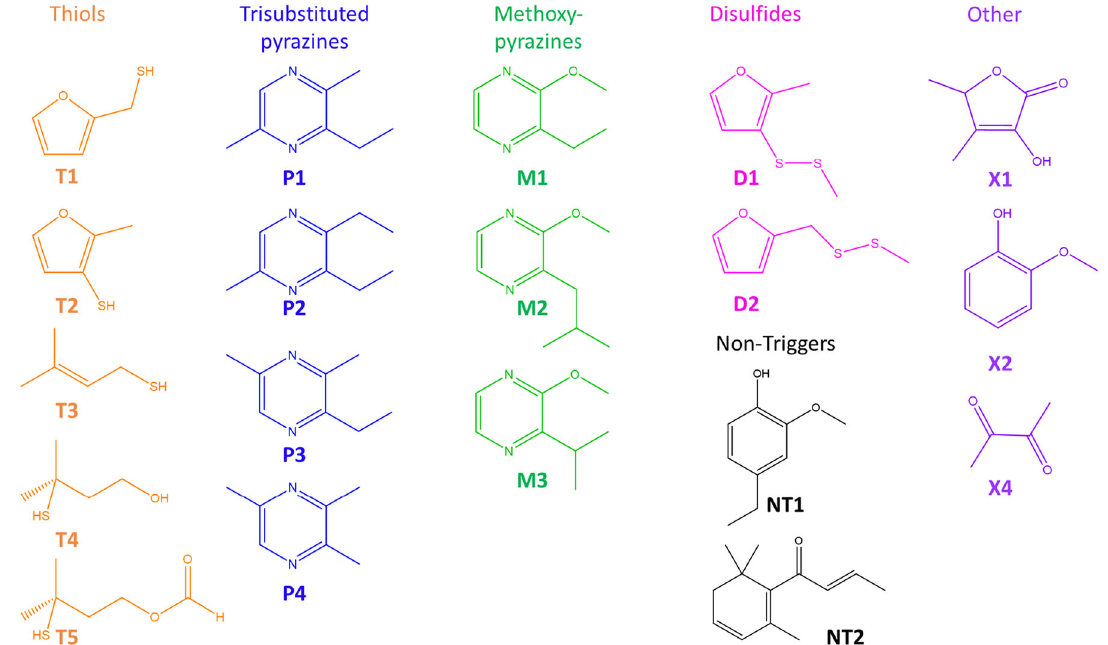
Fig. 2 Structures of the most frequently detected compounds. The most common trigger molecules are grouped into four distinct categories based on structure: thiols, trisubstituted pyrazines, methoxypyrazines, and disul fi des; although some less common triggers did not fall into any one of these